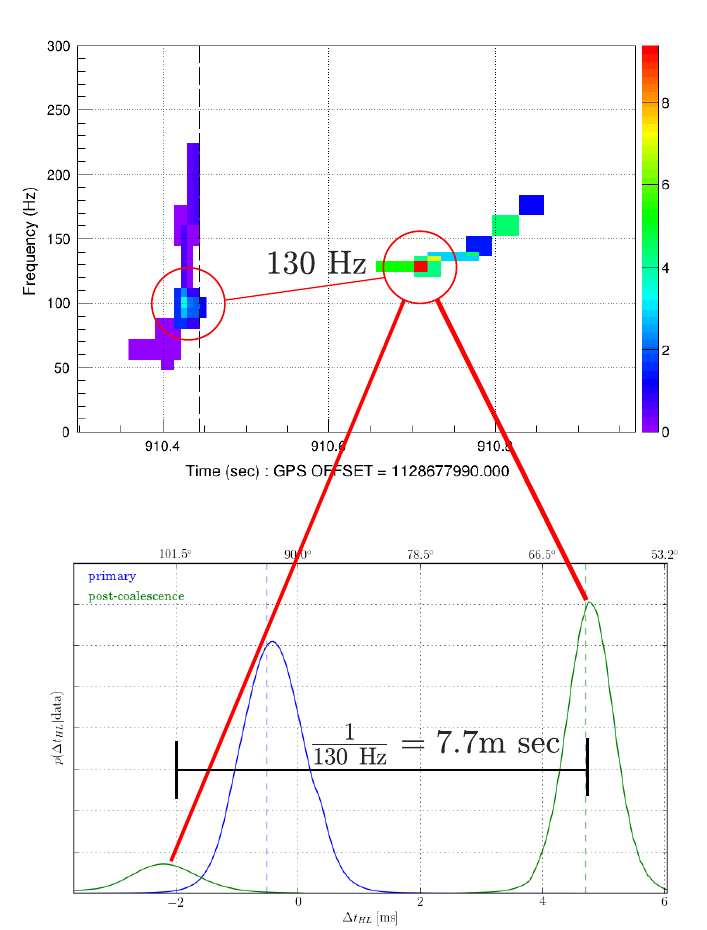
Figure 35. This plot shows how residual signal because of wavelength degeneracy can cause 7.7 m s = 1/ ( 130 Hz ) shift in maximum poster probability for time delay. The upper plot is residual · plot in Figure 32 and the plot below is the poster probability in Figure 34 for the event GW151012 [25].